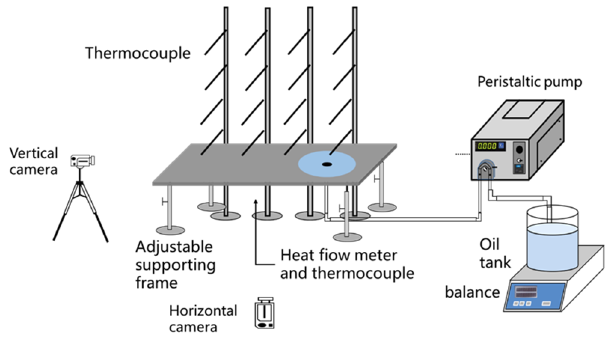
Figure 1. Diagram of experimental device.